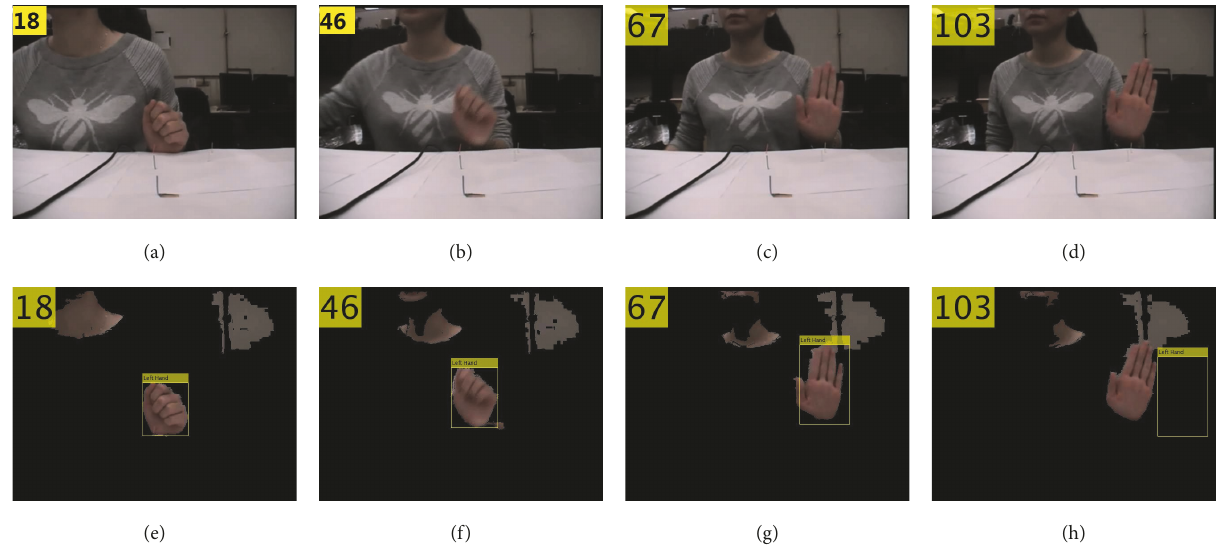
Figure 11: Sample frames clipped from gesture video with a hand blob overlapping with a background blob. The first row ((a), (b), (c), and (d)) shows the original frame captured by camera 𝐶 1 . The second row ((e), (f), (g), and (h)) shows the tracking result.